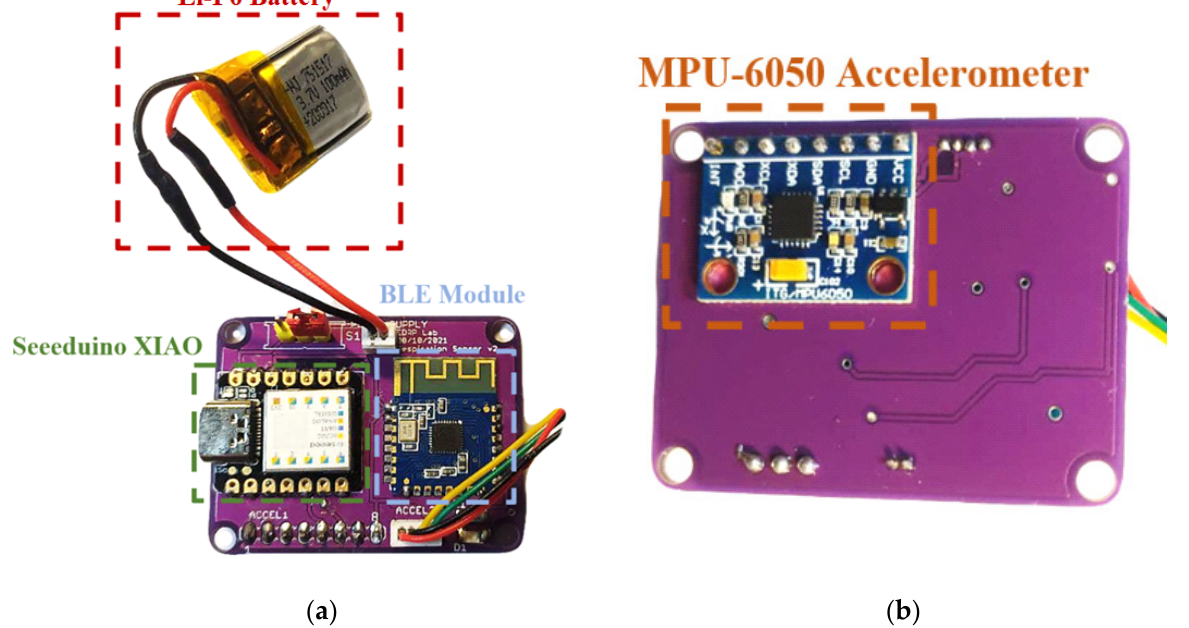
Figure 3. Front ( a ) and backside ( b ) views of the assembled board with main components high- lighted.